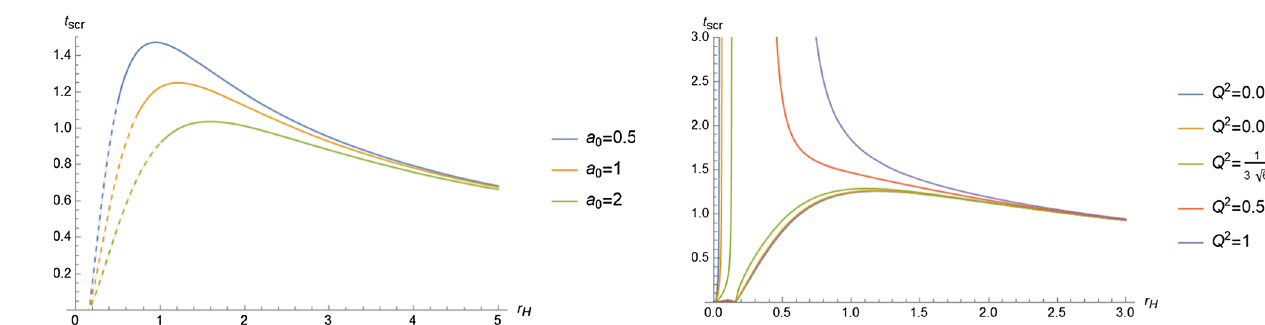
ferent charges, the black hole has different phase transitions.